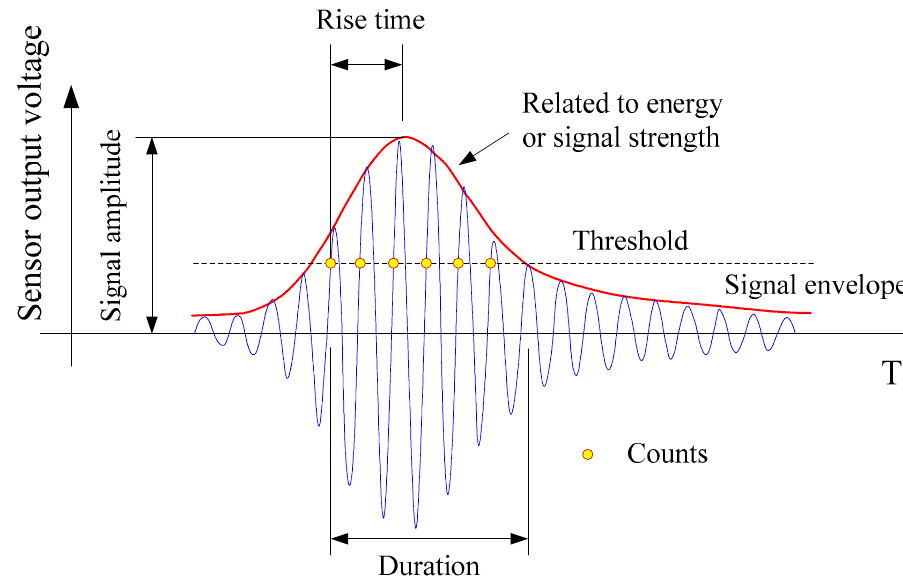
Figure 6. Typical AE signal and its characteristics [44].